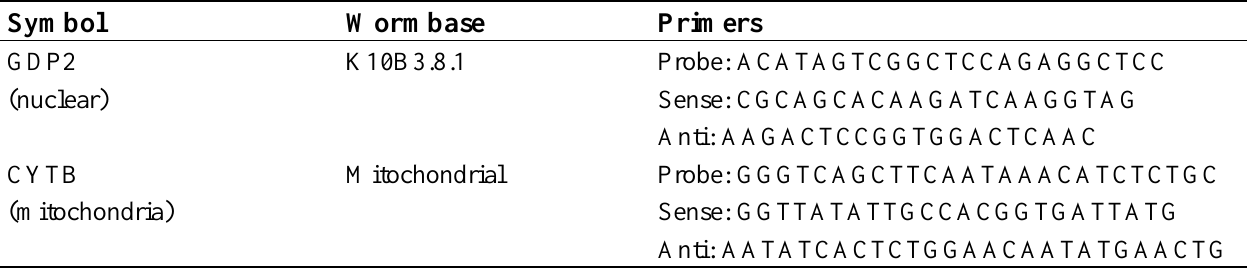
Table 1. Sequences and TaqMan probes of mtDNA used in this